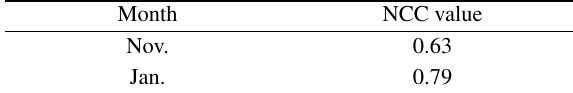
Table 15 NCC value between combined English and Arabic tweets (classified as nonself) and count of actual hospital visits.